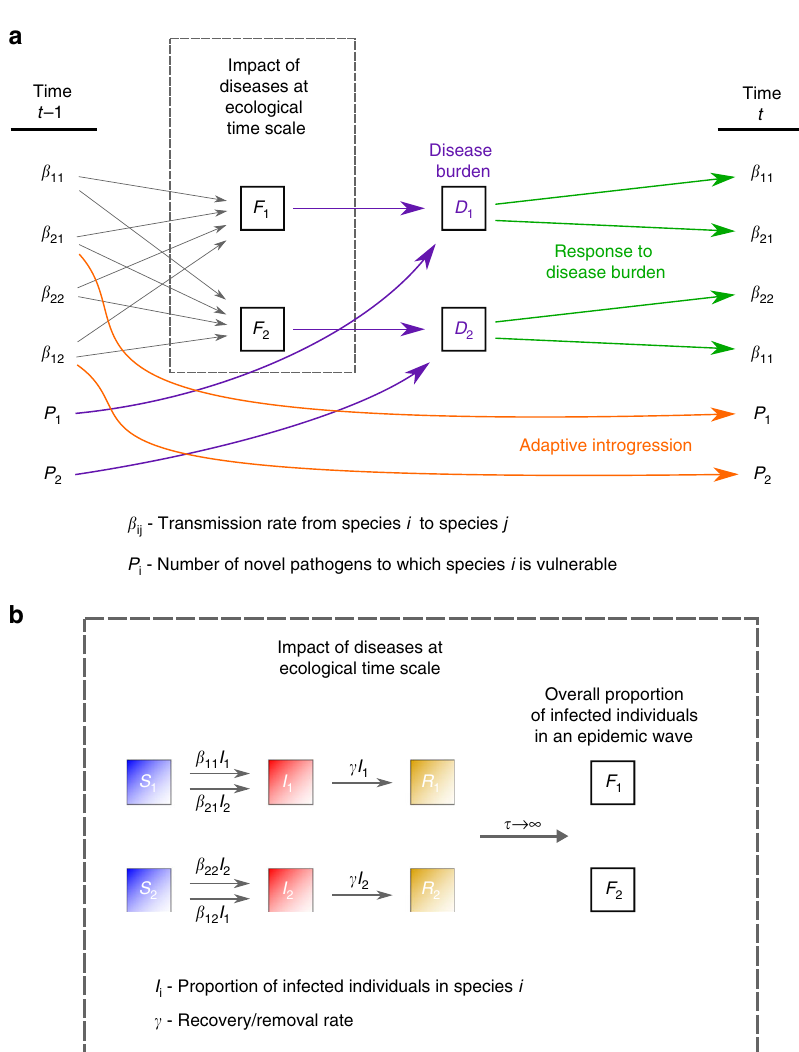
Fig. 2 Schematic representation of the two-time-scales model. The model describes disease and introgression dynamics between two species. The fi gure shows the transition between two time steps at the evolutionary time scale, t (cid:2) 1 and t . a Transmission rates β ij ( i ¼ j , within-species transmission; i ≠ j , between-species transmission from species i to species j ) determine the average impact of pathogens F i at the ecological time scale, according to Eqs. (3)- (9). The pathogen package size P i and the average impact of each pathogen F i determine the disease burden D i (purple), according to Eqs. (1) and (2). The species respond to disease burden by adjusting contact rates β ij (green), according to Eqs. (10) – (13). Inter-species contact results in gene fl ow and adaptive introgression, reducing pathogen package sizes P i (orange), according to Eqs. (14) and (15). b Impact at the ecological time scale (dashed box in a ) is modeled in an SIR epidemic framework, as the average impact of an epidemic. Individuals transition from state S (susceptible) to state I (infectious) from either within-species infections or between-species infections (Eqs. (3) – (8)). Individuals in state I transition to state R (recovered/removed) at rate γ (Eqs. (3) – (8)). The impact of an epidemic F i is measured as the overall proportion of individuals in species i infected throughout the run of the epidemic